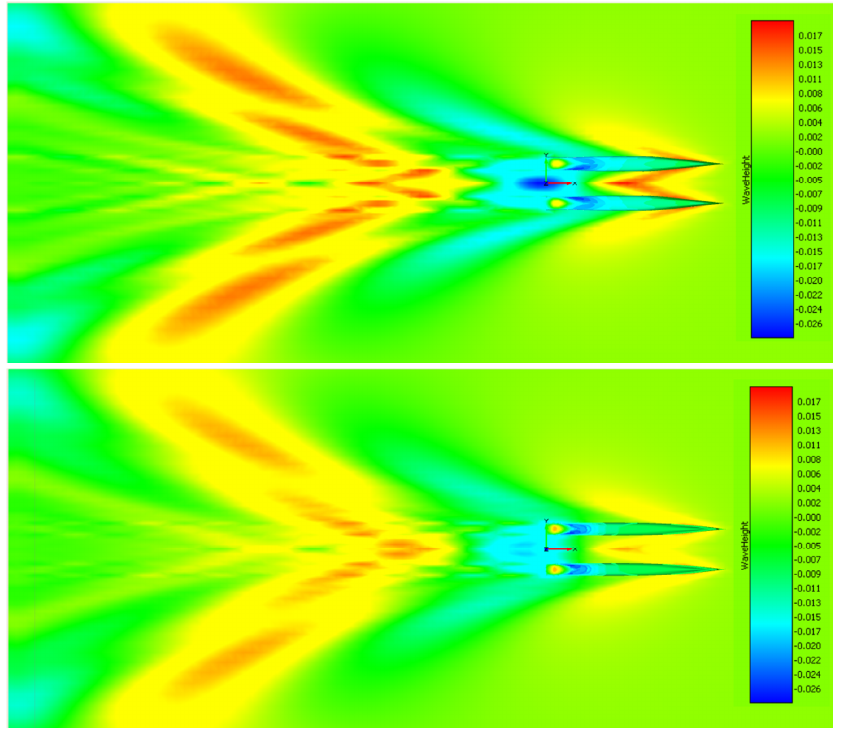
Figure 11. Wave patterns of optimized 30 m catamarans with demihull beam constraint (up) and demihull beam relaxed (down).